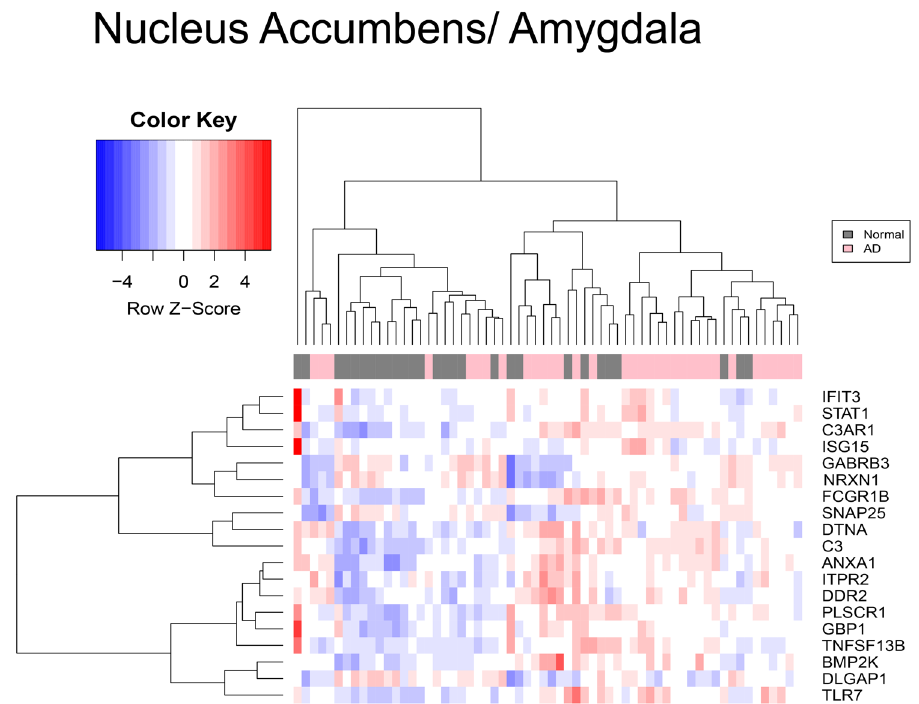
Figure 3. Heatmap of mRNA expression in nucleus accumbens and amygdala AD patients. This figure represents the expression value of mRNA from the Nucleus accumbens and Amygdala of AD and controls patients’ brains in GSE84422. The data were normalized using the GCRMA Bioconductor package. The mRNA expression of PLSCR1, DTNA, BMP2K, IFIT3, DDR2, ITRP2, TLR7, ANXA1, GBP1, SNAP25, NRXN1, DLGAP1, GABRB3, STAT1, ISG15, C3AR1, and C3 were chosen by comparing independent SAM results and identifying common markers that were shared between pathologies. The color key represents the Z score the blue represents underexpression and red represents overexpression. SAM results demonstrate that mRNA expression of DTNA was overexpressed while transcripts ANXA1, DDR2, ITRP2, BMP2K, C3, C3AR1, and TLR7 were